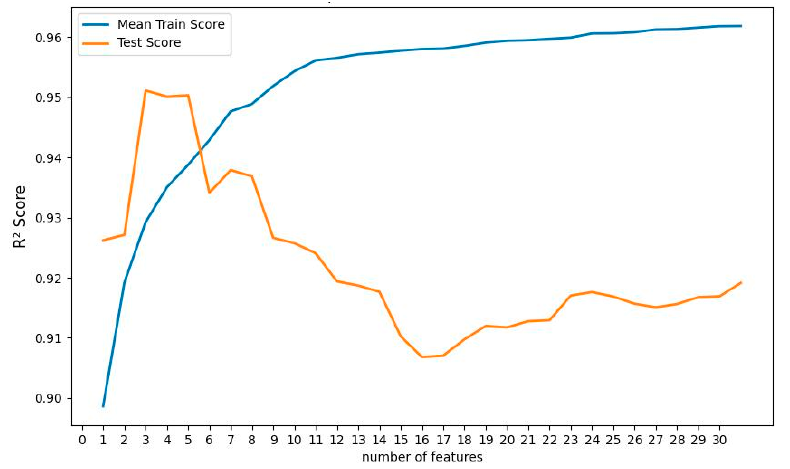
Figure 12. R 2 score for the training set and testing set with the different number of features (ranked) used in MLR.